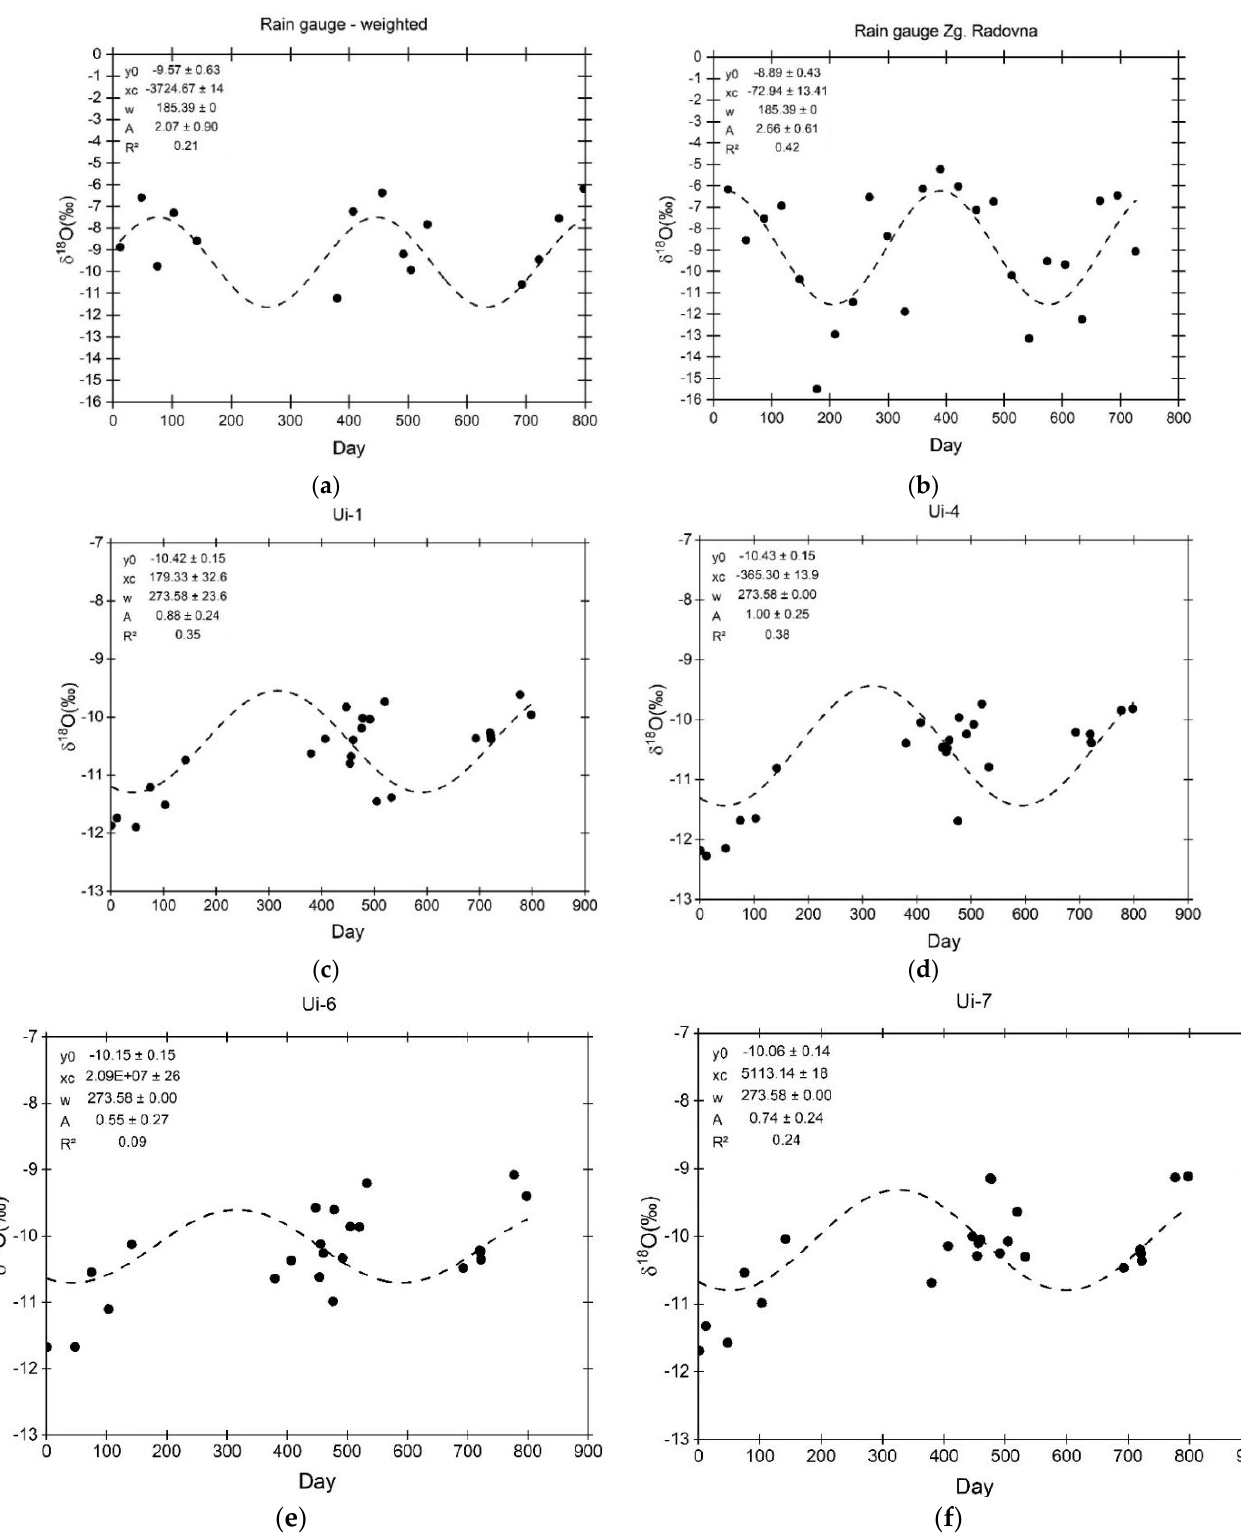
Figure 6. Seasonal sine wave fit between observed and modeled δ 18 O values in precipitation: rain gauge Urbas — weighted ( a ); rain gauge Zgornja Radovna ( b ); water in springs Ui-1 ( c ), Ui-4 ( d ), Ui-6 ( e ), and Ui-7 ( f ). Table 5. Estimated MRT of water in springs in the Urbas landslide.